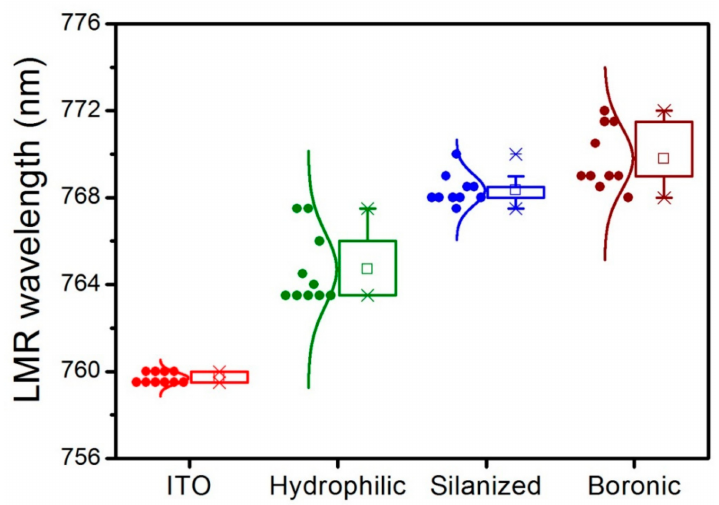
Figure 7. Statistics diagram of the LMR wavelength for four-status surface modification.